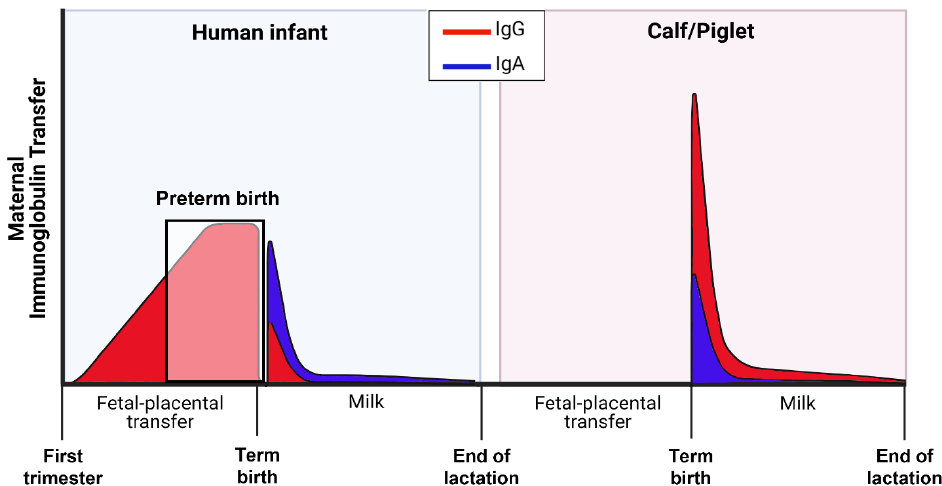
Figure 3. Comparison of maternal immunoglobulin transfer to newborn infants and calves/piglets. The figure illustrates the species differences in the time and mode of maternal immunoglobulin isotype (IgG and IgA) transfer via fetal placental transfer in utero and/or postnatal consumption of colostrum and milk after birth [28,41–44]. The shaded box shows how premature birth may lead to incomplete maternal fetal–placental transfer of IgG in human infants (created with BioRender.com; accessed on 19 May 2021) [43].